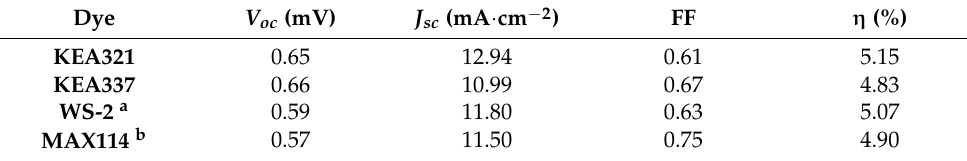
Table 7. DSSCs characteristics for the best devices using the KEA sensitizers.